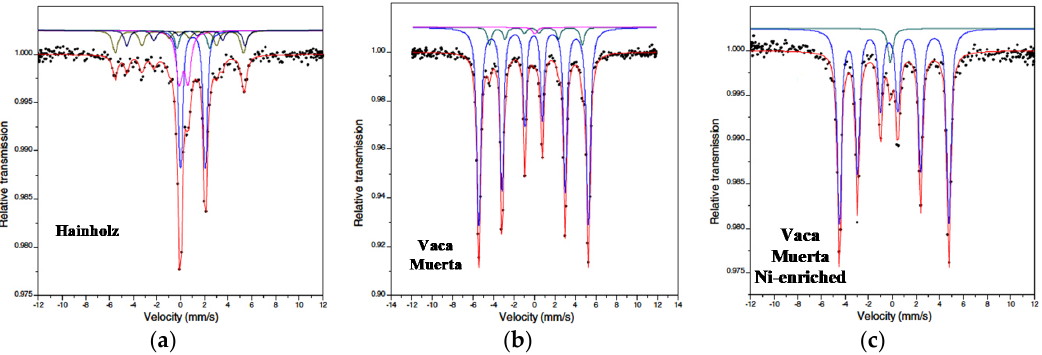
Figure 21. Room temperature Mössbauer spectra of mesosiderites: Hainholz Mes-A4 ( a ), metal-rich areas of Vaca Muerta Mes-A1 ( b ), and Ni-enriched metal-rich areas of Vaca Muerta ( c ). Indicated spectral components are the results of the fits. Adapted from [42].